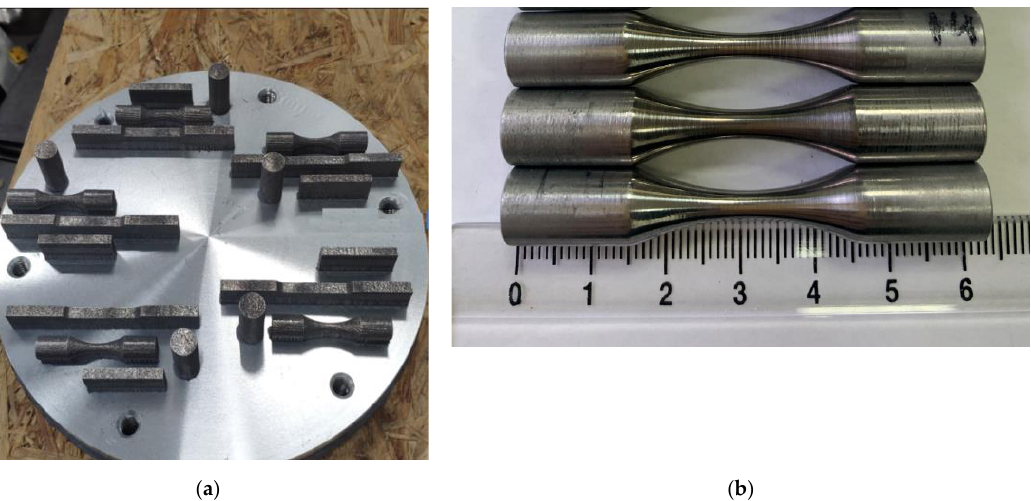
Figure 3. The powder particles of AlSi10Mg used for VHCF specimens with different magnifications ( a , b ). The analysis on the particle shape and size (Figure 3a) have shown a significant difference in radios of an individual particle. The diameter of the spherical particle is varied from 10 to 80 micrometers. The average particle size is about 25 micrometers. The entire observed particle has small (few micrometers) satellites at the sphere surface (Figure 3b). A small companion refers to an attached small particle whose dimensions are much smaller than the main particle, but which disturbs the geometry of the powder and can potentially lead to negative effects during subsequent sintering. The important micro pores present were not observed. Also, some particles have elongated ellipsoid and dumbbell shapes. SLM specimens were built directly in the hourglass specimen shape used for VHCF tests (Figure 4a).